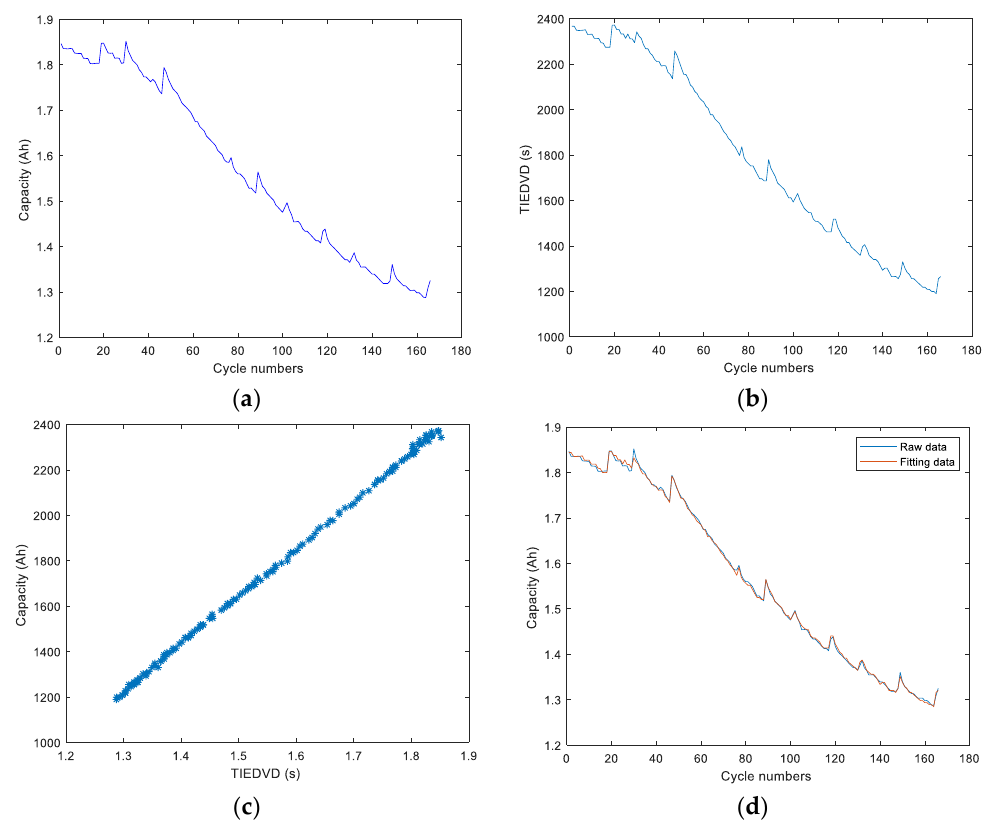
Figure 5. Indirect HI construction process: ( a ) capacity curve; ( b ) indirect HI curve; ( c ) correlation curve between indirect HI series and Li-ion battery capacity series; ( d ) mapping construction using polynomial fitting.